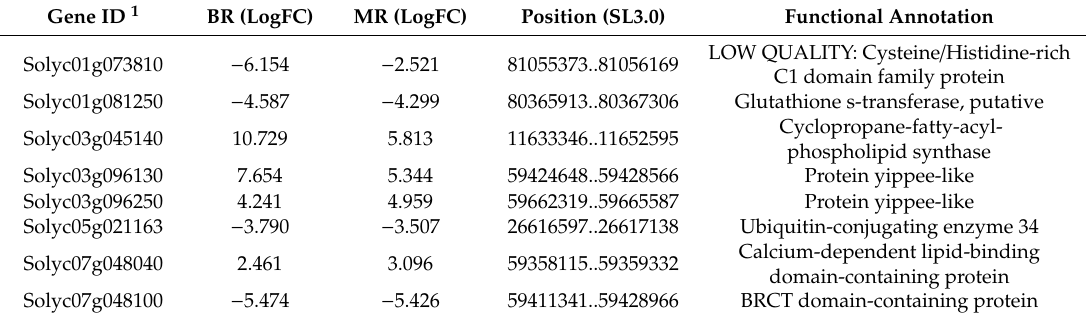
Table 2. Di ff erentially expressed genes between R182 and M82 commonly identified at breaker (BR) and mature red (MR) fruit